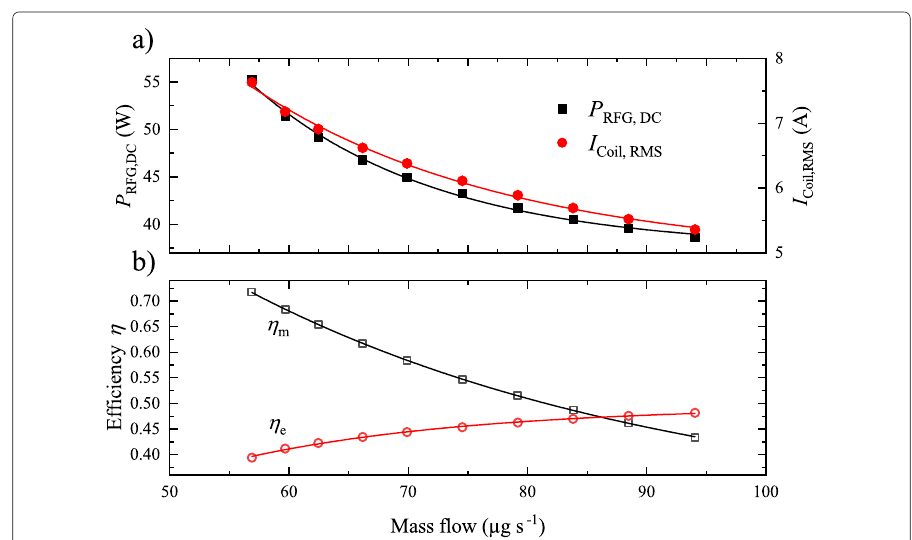
Fig. 9 a ) Experimentally determined performance-mapping for a screen grid current of 30mA and determined coil current of the RIT-4. The voltages applied to the grids are 1200V to the gas inlet of the thruster, thus biasing the screen grid by the same voltage, and − 150V to the acceleration grid. The required input power of the RFG is represented by filled squares, while the root mean square of the coil current is represented by filled circles. b ) Efficiency of the RIT-4. The mass efficiency is depicted by open square, the electrical efficiency by open